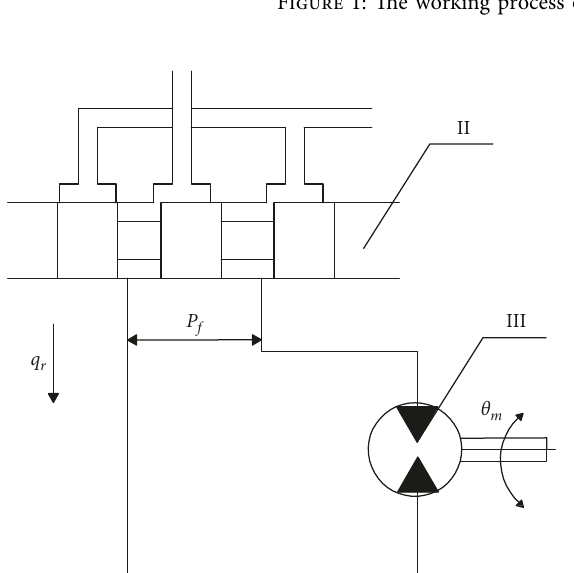
Figure 2: The structure sketch of the valve-controlled hydraulic